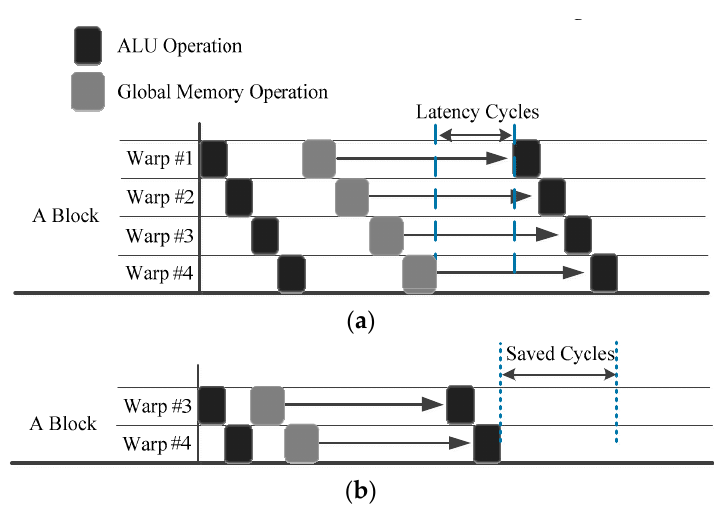
Figure 7. Inter-thread execution order simulation: ( a ) Execution order with ILP0; ( b ) Execution order with ILP 1 = 2 × ILP 0 .